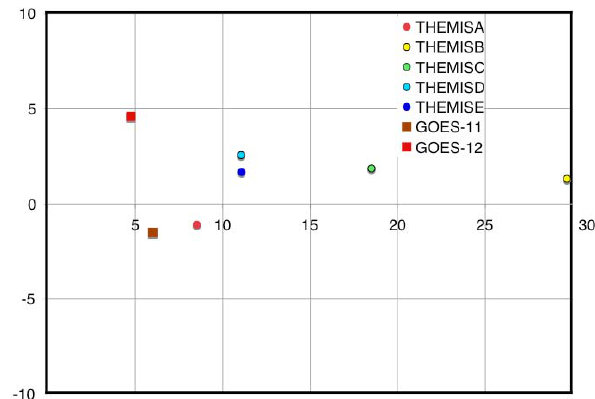
Fig. 1. THEMIS satellite positions GSM x and y in units of R E for Figure 1.THEMIS satellite positions GSM x and y in units of R e for February 2, 2008 at 2 February 2008 at 08:00UT. 08:00 UT.